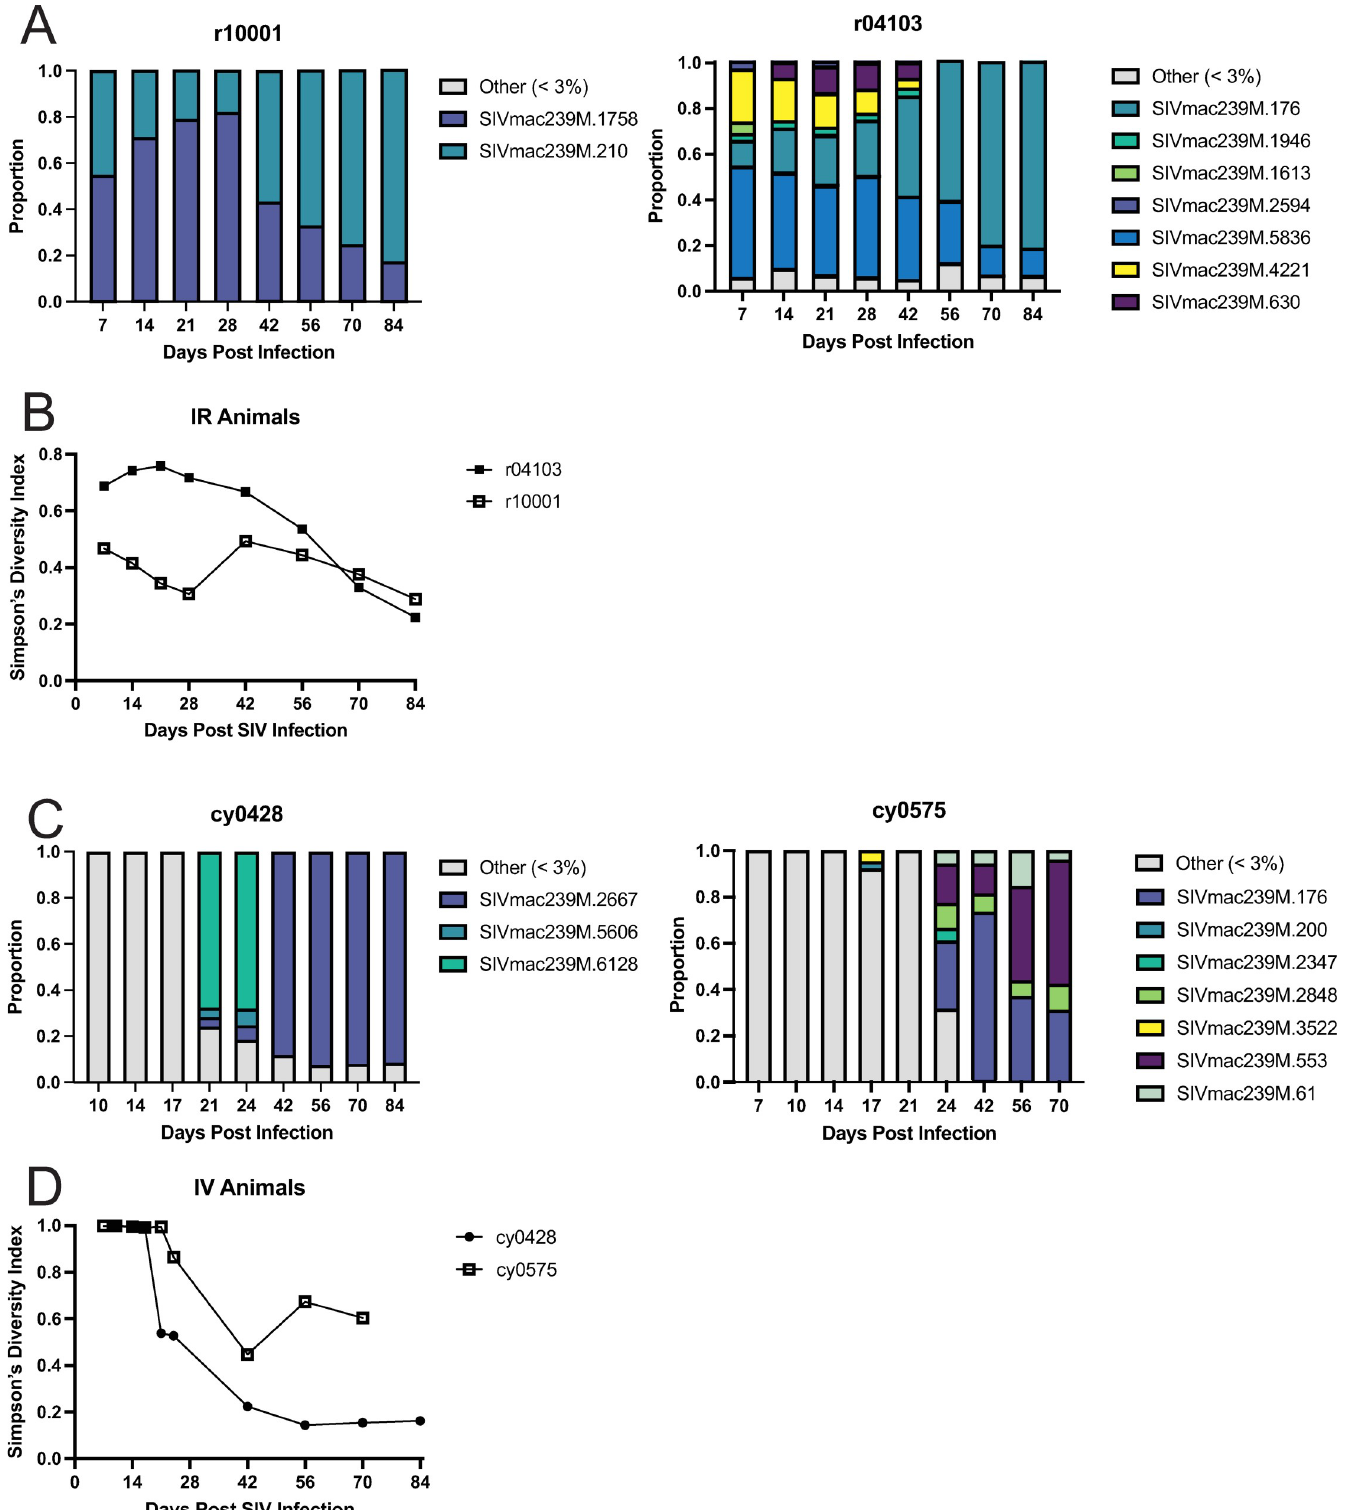
Fig 3. Diversity of the molecular barcodes present in the circulating virus populations. The proportion of individual barcoded lineages circulating in the IR- challenged rhesus (A) and IV-challenged cynomolgus macaques (C) are shown over time. Variants that do not exceed 3% proportion at any point throughout infection